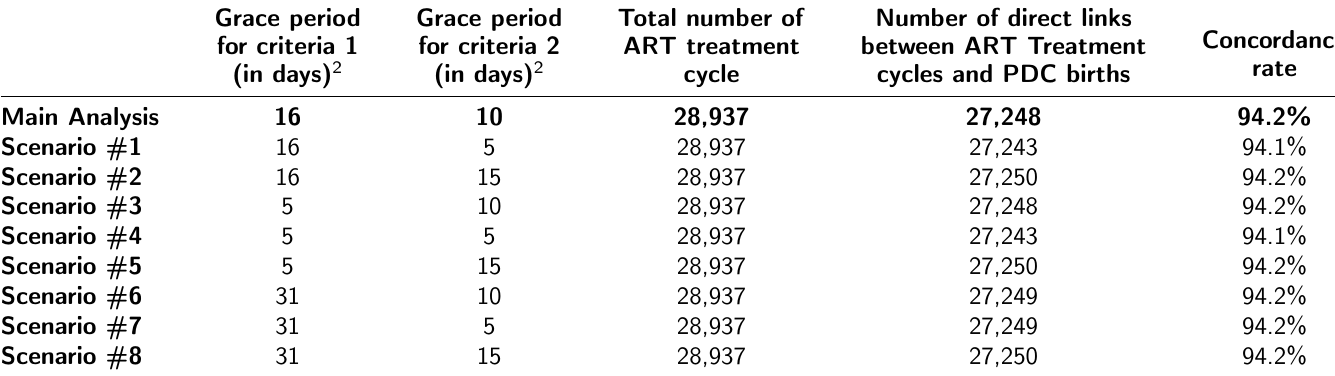
Supplementary table 2: Sensitivity analysis of the concordance rate between ANZARD and New South Wales (NSW) and Australian Capital Territory (ACT) perinatal data collection for the final linked data of the medically assisted reproduction (MAR) data linkage,